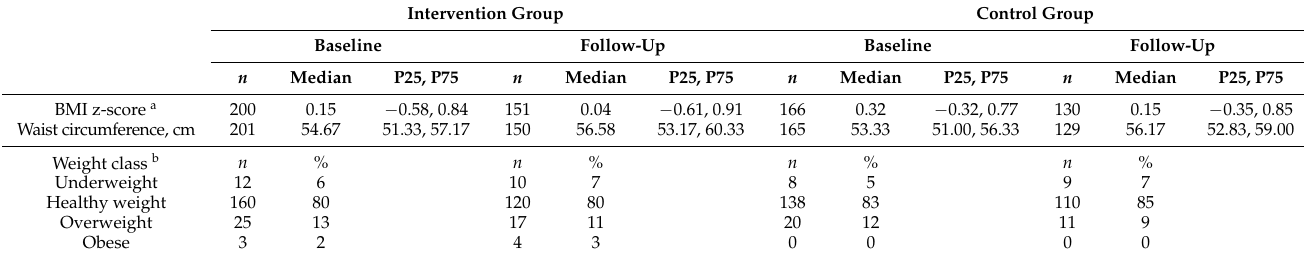
Table 2. Baseline and follow-up summary statistics for anthropometric measures.